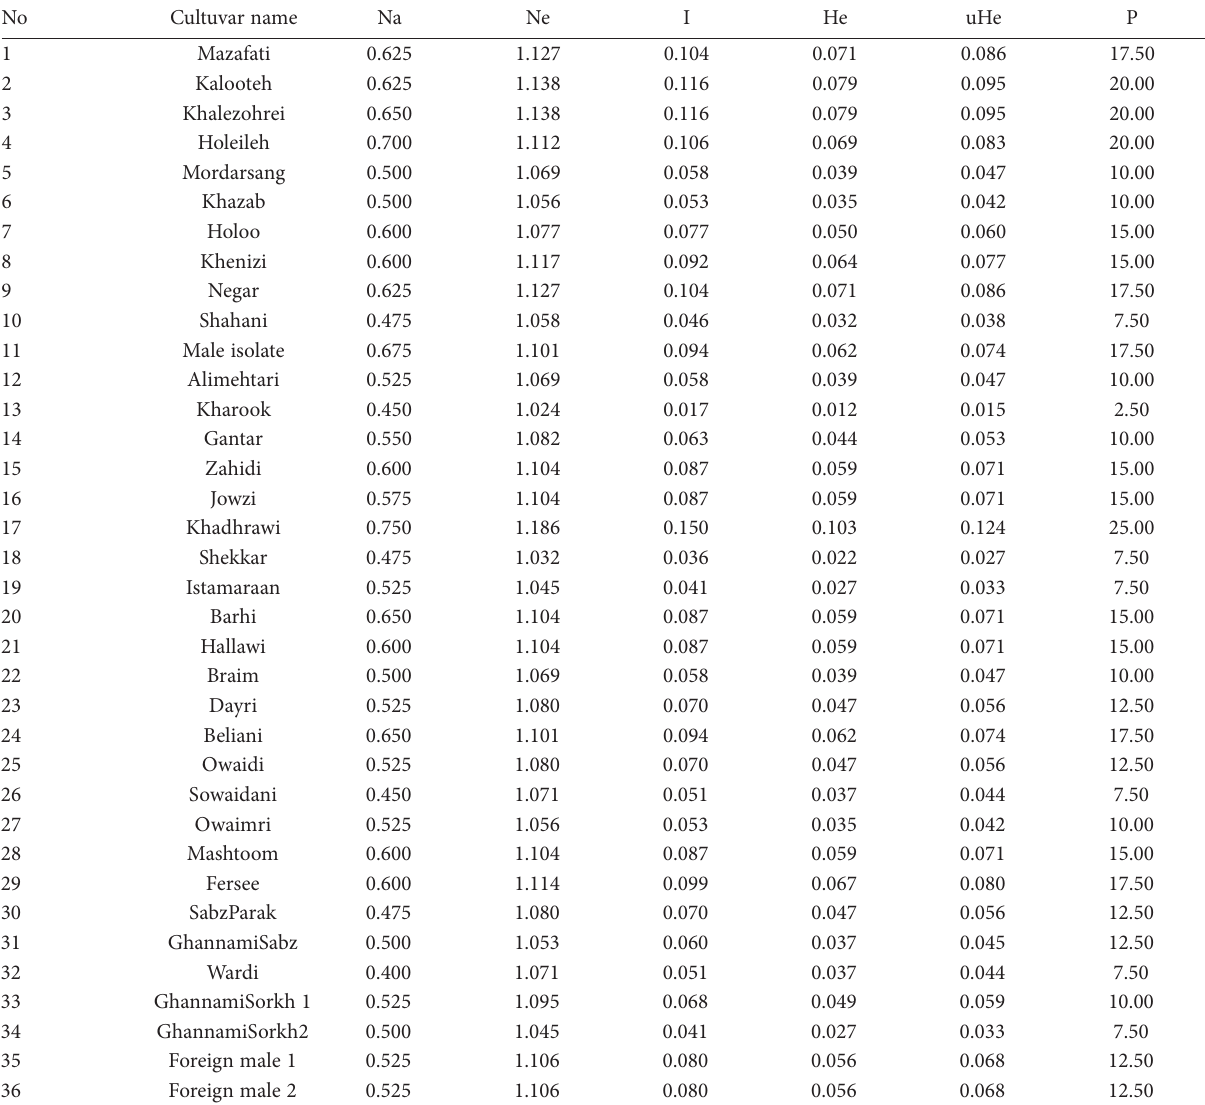
Table S3. Genetic diversity parameters in date palm